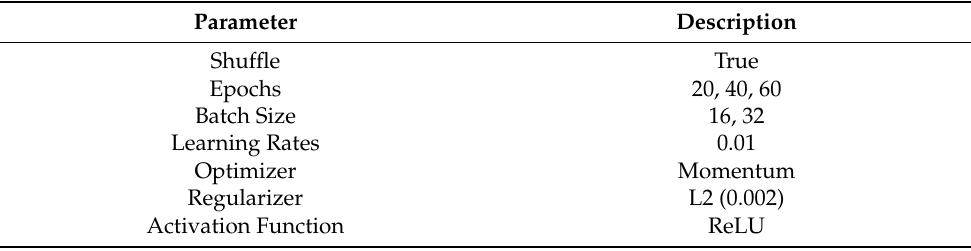
Table 2. Hyper-parameter of deep neural